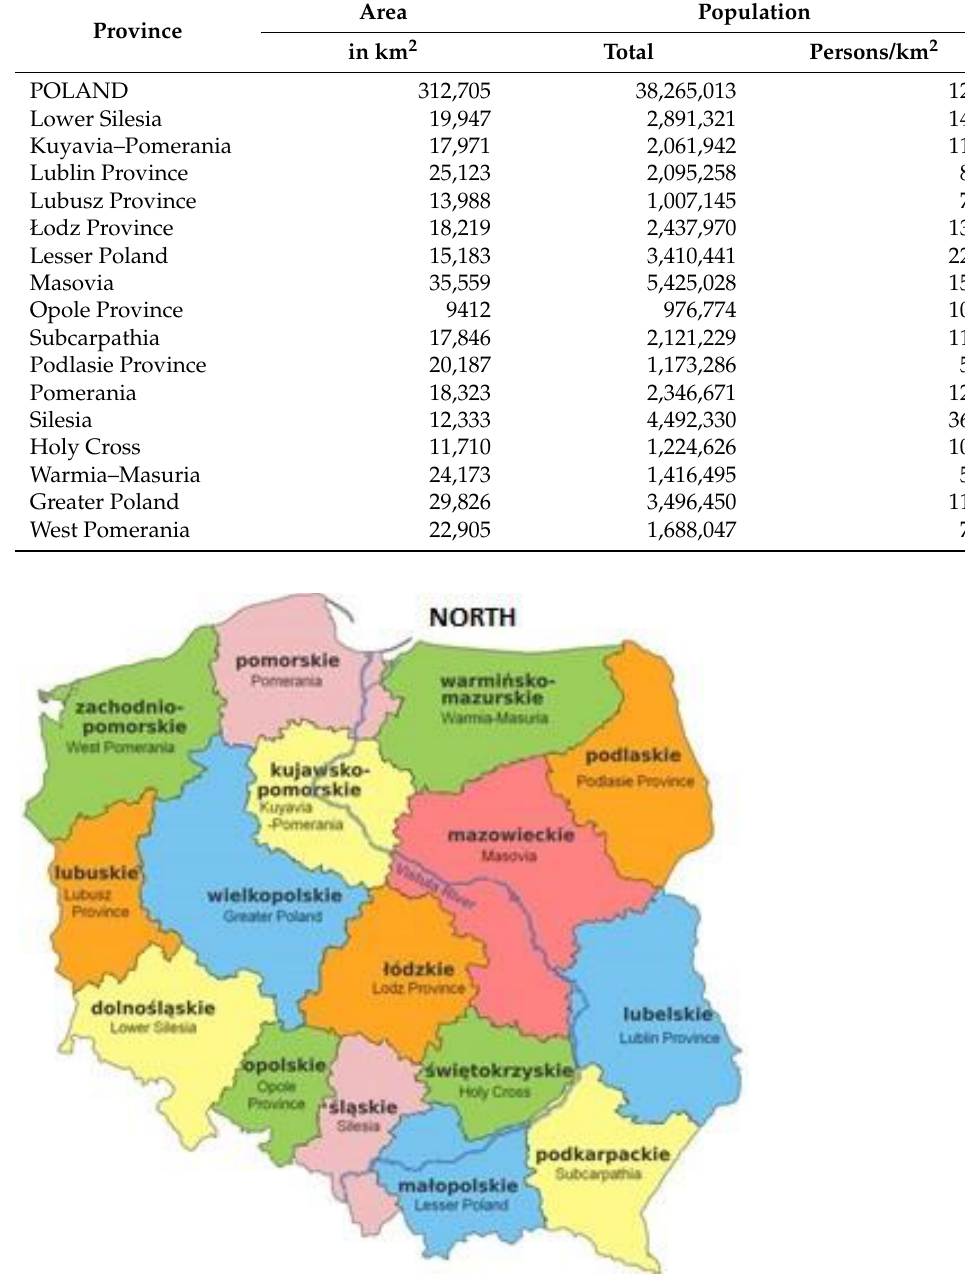
Figure 3. Accident number per 100,000 population in 2020 [62].